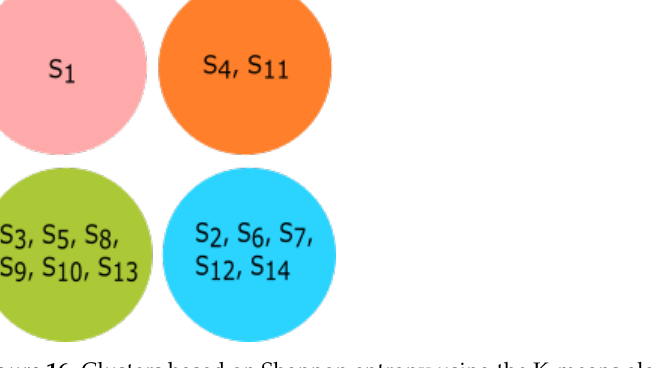
Figure 16. Clusters based on Shannon entropy using the K-means algorithm. Here, S i represents the species name as specified in Table 1.